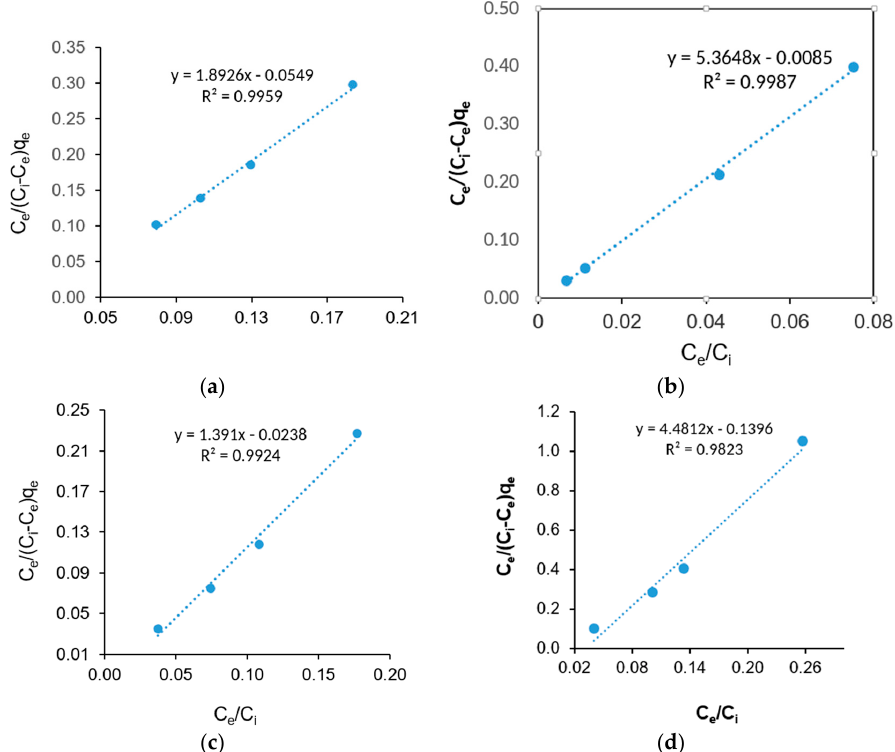
Figure 6. BET adsorption isotherm modeling for the removal of ( a ) COD; ( b ) BOD; ( c ) SS; and ( d ) NH 3 from SRPE using FeSO 4 ·7H 2 O as a coagulant.